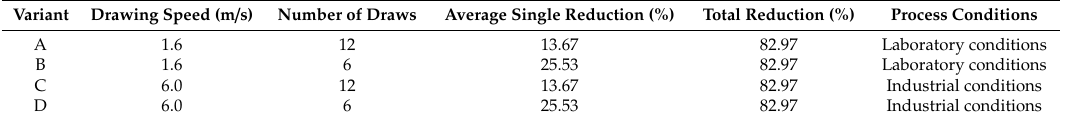
Table 1. Drawing parameters for various drawing speeds and single reductions.